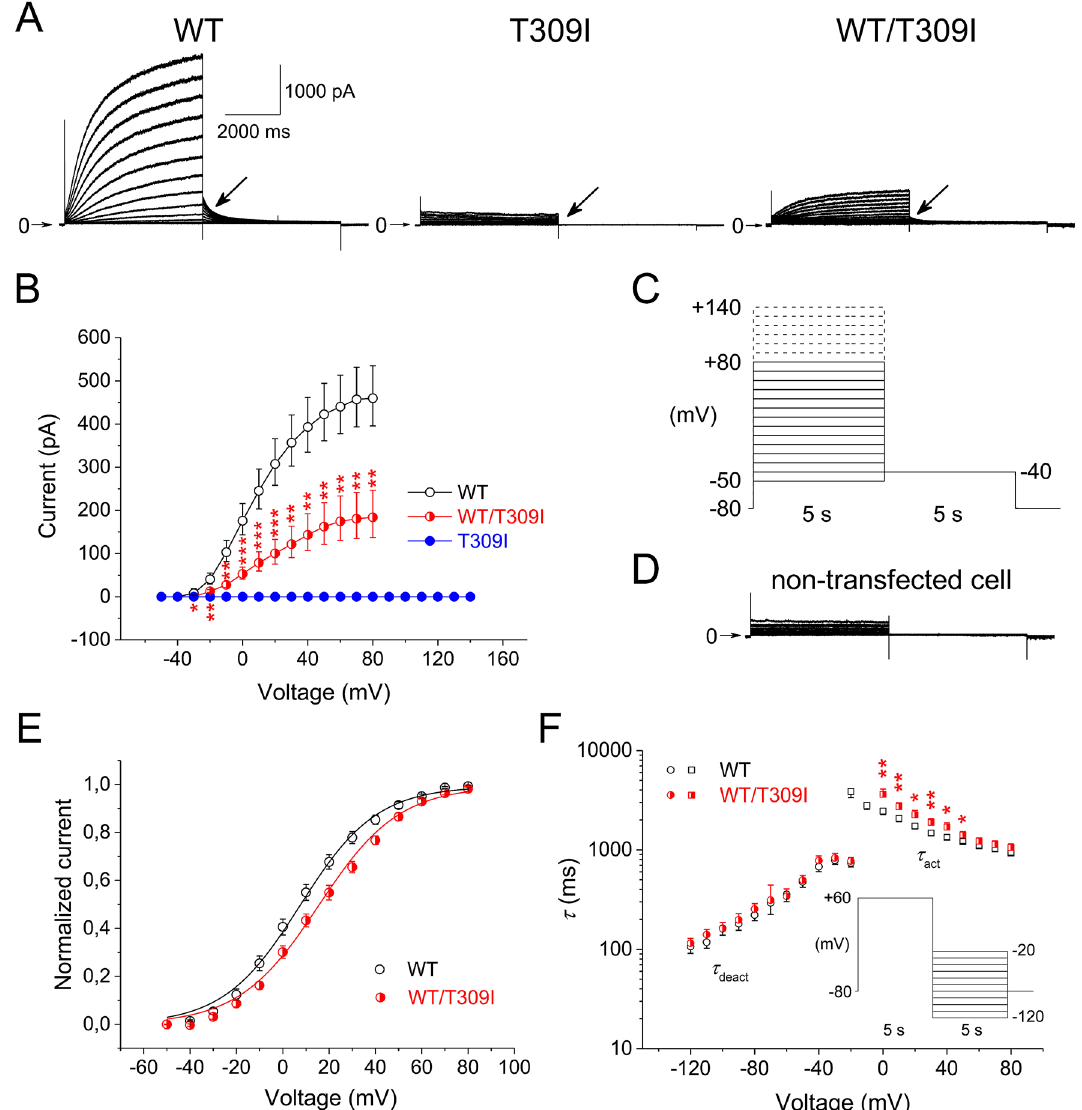
Figure 2. Biophysical impact of T309I mutation. ( A ) Representative records in wild type (WT), T309I, and WT/T309I channels (KCNE1 subunit cotransfected); arrows point to the tail current. ( B ) Average voltage dependence of tail current activation ( n = 20, 9, and 16 in WT, T309I, and WT/T309I channels, respectively); the half-maximal activation voltage V 1/2 = 8.3 ± 2.2 mV in WT channels and 15.6 ± 2.1 mV in WT/T309I channels; P < 0.05). ( C ) Activation experimental protocol; the dashed lines—steps used for stimulation only in T309I channels. ( D ) Representative trace from a non-transfected CHO cell. ( E ) Average voltage dependence of steady- state activation. ( F ) Average voltage dependence of the time constant of activation (τ act ) and time constant of deactivation (τ deact ; n = 11 and 9 in WT and WT/T309I channels, respectively); inset: deactivation experimental protocol; *, ** and ***statistical significance between WT and WT/T309I channels at P < 0.05, 0.01 and 0.001, respectively. The stimulation frequency was 0.08 Hz. All graphs were prepared using the software Origin, version 8.5.1. For the fluorescence image acquisition, a confocal laser scanning microscope Leica TCS SP8 X ( Leica microsys- tems , Wetzlar, Germany) was used. WT and T309I human KCNQ1 tagged with GFP at the 3 ′ -terminus, or WT- KCNQ1 without GFP in a pBK-CMV vector, as well as WT human KCNE1 in a pBK-CMV vector were transfected into CHO cells seeded on glass bottom dishes ( Cellvis , Mountain View, CA, USA) coated with fibronectin ~ 48 h before the evaluation ( KCNQ1 and KCNE1 in the molar ratio 1:2). In some experiments, WT with no GFP was cotransfected with the GFP-tagged T309I- KCNQ1 and KCNE1 , and the cell membrane was stained (CellMask Orange Plasma Membrane Stain; Invitrogen , Carlsbad, CA, USA). Detailed description is provided in the Supplementary Methods. The chemicals were purchased from Sigma- Aldrich (Prague, Czech Republic) unless otherwise